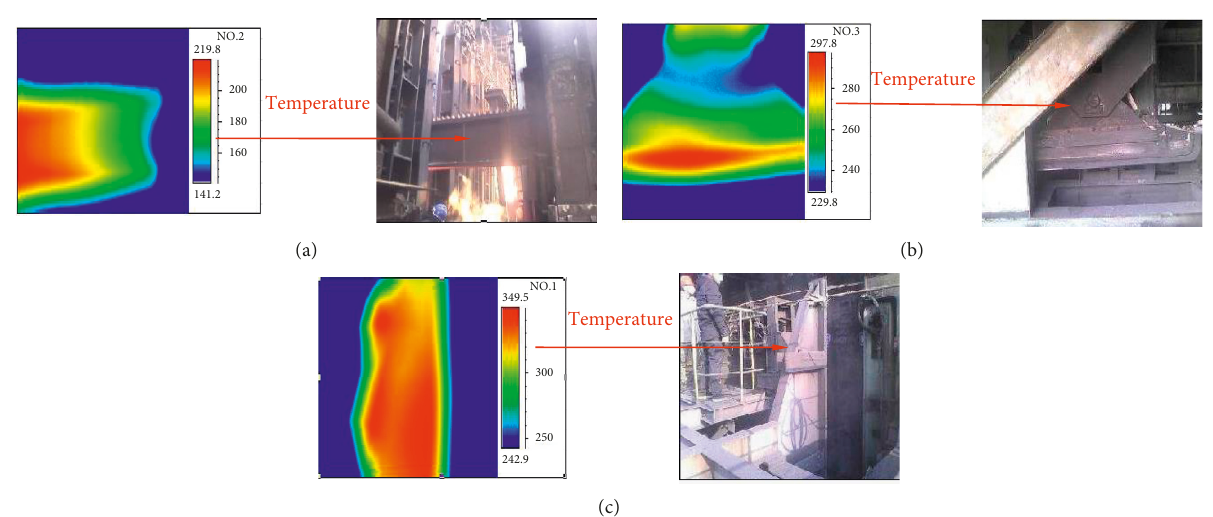
Figure 3: Test results of infrared thermal imager. (a) Test position and temperature of rod. (b) Test position and temperature of slipper. (c) Test position and temperature of head.